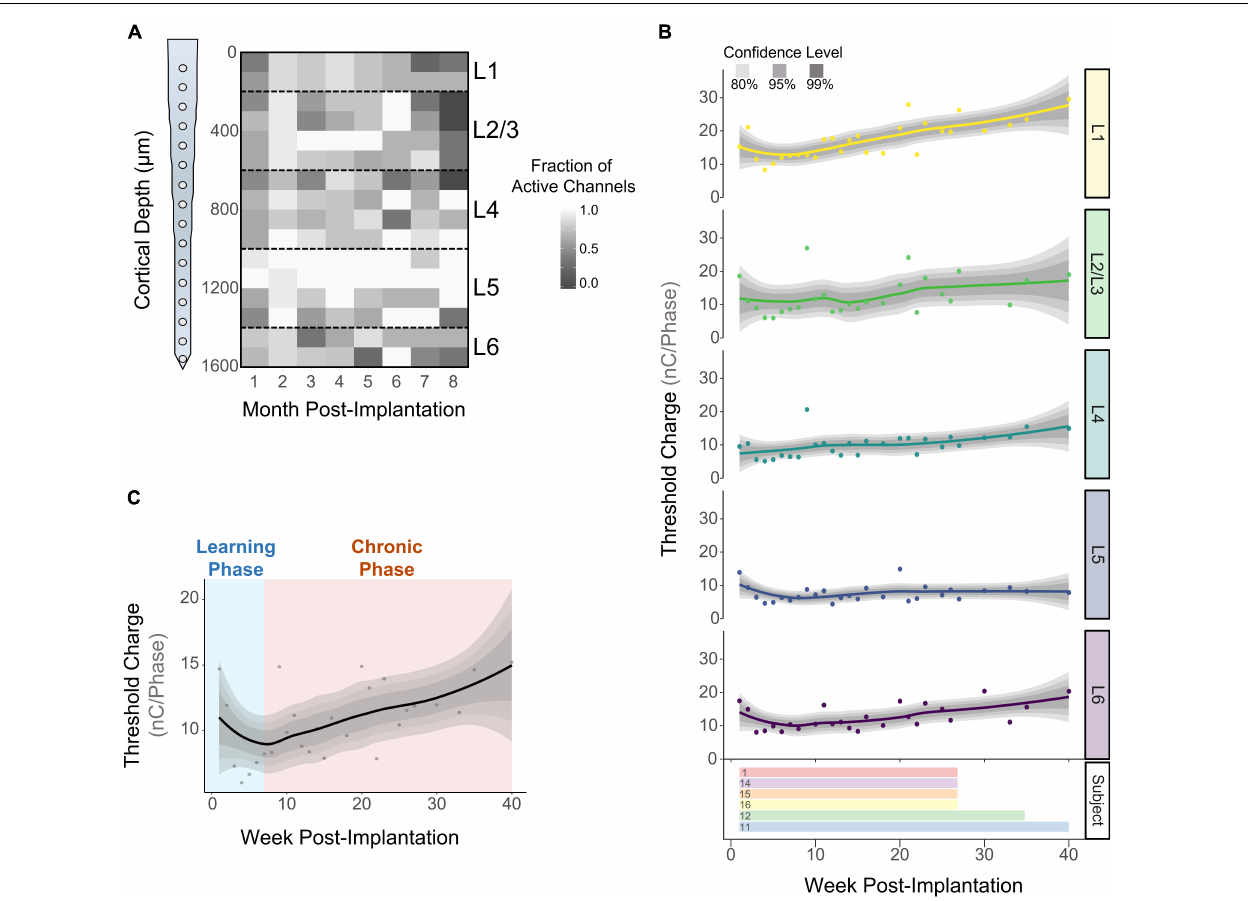
FIGURE 3 | Long term stability of ICMS across cortical layers. The fraction of active channels was computed by assessing the number of times an electrode-site was able to elicit thresholds at safe ICMS charges. (A) Average fraction of active channels over time across subjects ( N = 6). (B) Longitudinal detection thresholds across cortical layers (top) and the amount of time post-implantation in which detection thresholds were obtained from each subject (bottom). (C) Average detection thresholds of all cortical layers showing an initial decrease in thresholds (learning phase), followed by a period of increased thresholds (chronic phase) ( N = 6). For (B,C) : lines represent a locally fitted polynomial regression of the means and shaded areas represent confidence